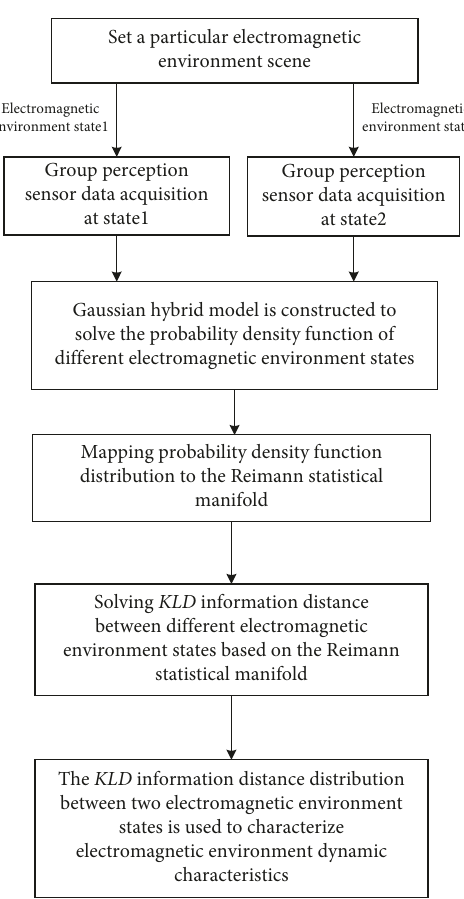
Figure 4: Algorithm procedural steps for electromagnetic envi- ronment dynamic